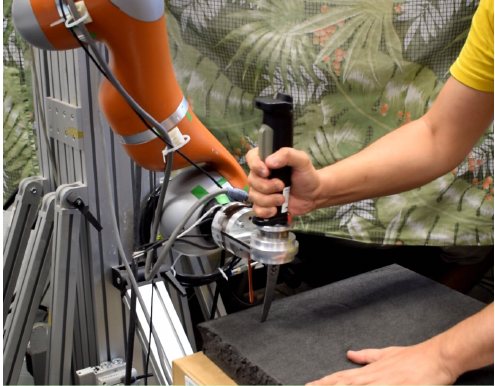
Figure 15. Comparison of sensor A and sensor B.